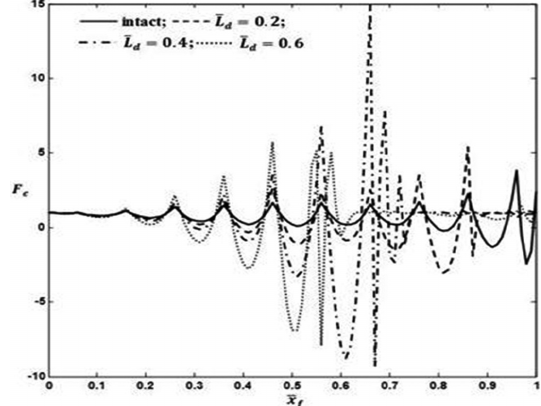
(cid:6) Fig. 10. Effects of delamination length on the oscillator separation (cid:7) L 1 = 0 . 3 , interface 1 from the beam .